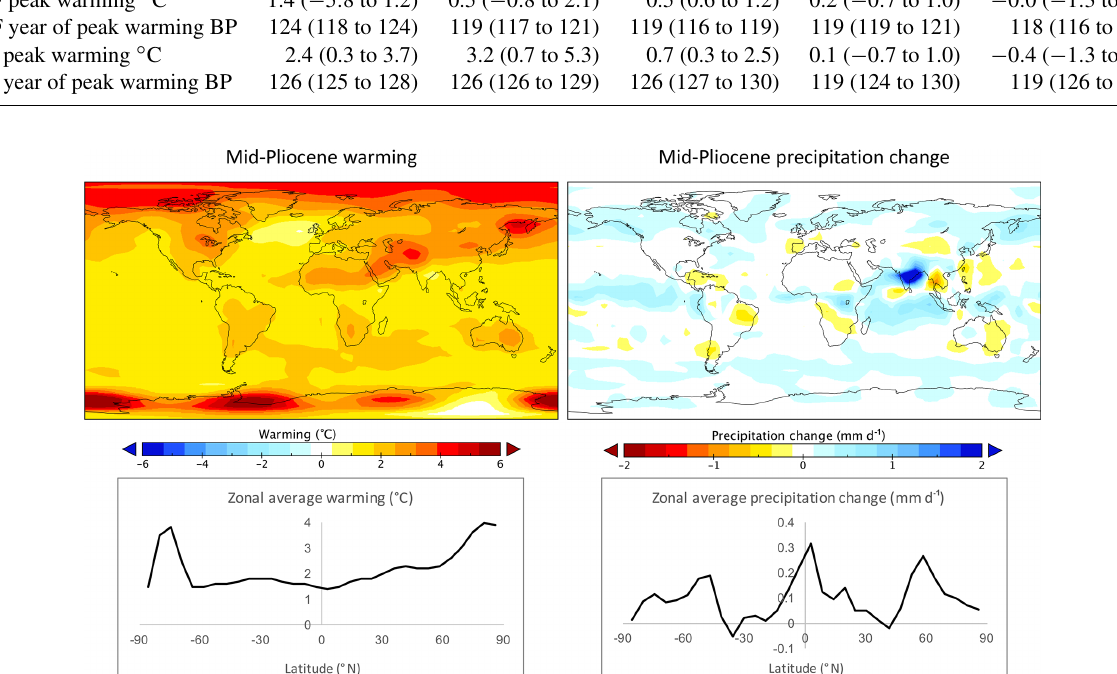
Figure 7. Emulated mid-Pliocene temperature and precipitation anomalies with respect to pre-industrial values. The ice-sheet and orbital inputs are set to pre-industrial values, and the emulated change is driven by an assumed CO 2 concentration of 405ppm.